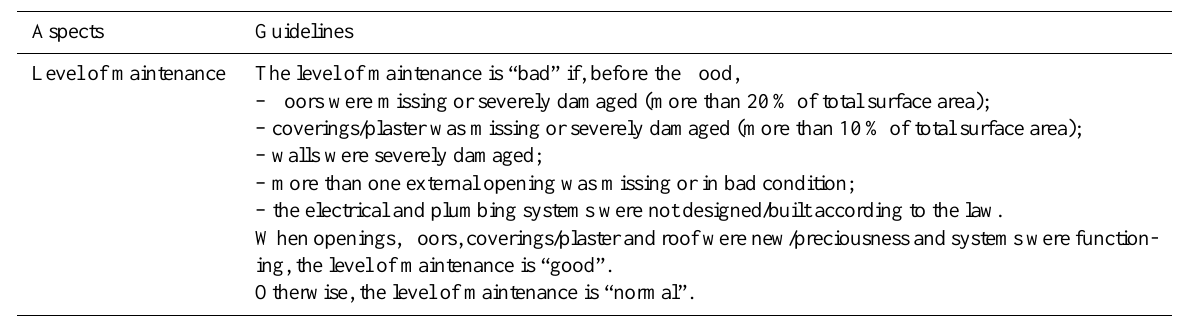
Table 5. Extract from the guidelines on the level of